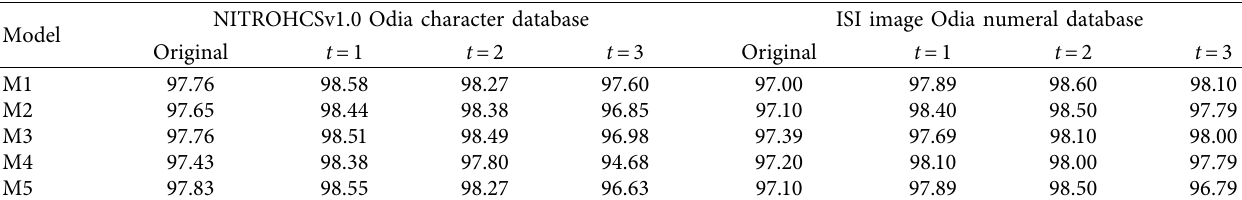
Table 3: Efect of translation on performance. t is the parameter describing the amount of